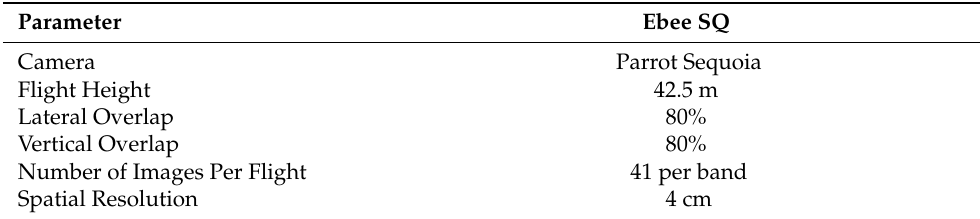
Table 1. Parameters for flight planning.